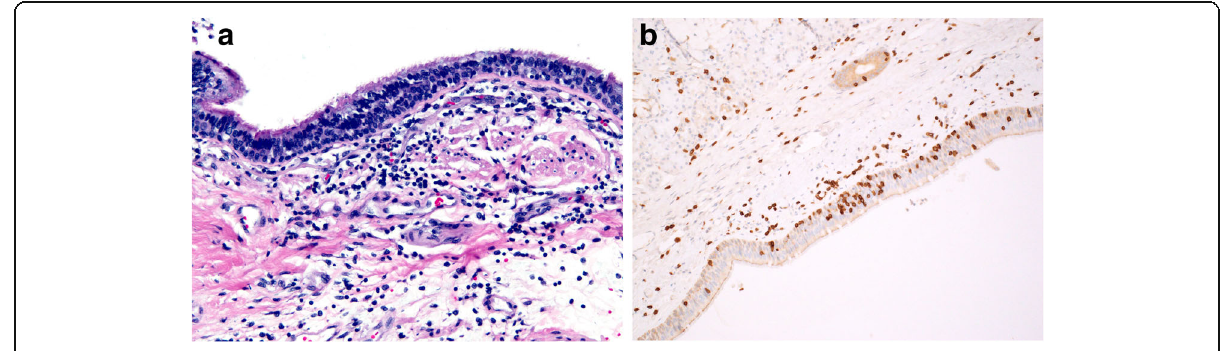
Fig. 8 Airway inflammation in COVID-19: a Chronic inflammation composed mainly of lymphocytes, involving the bronchial mucosa (Hematoxylin & eosin, original magnification × 200). Note that blood vessels are free of thrombi; b CD3 demonstrates